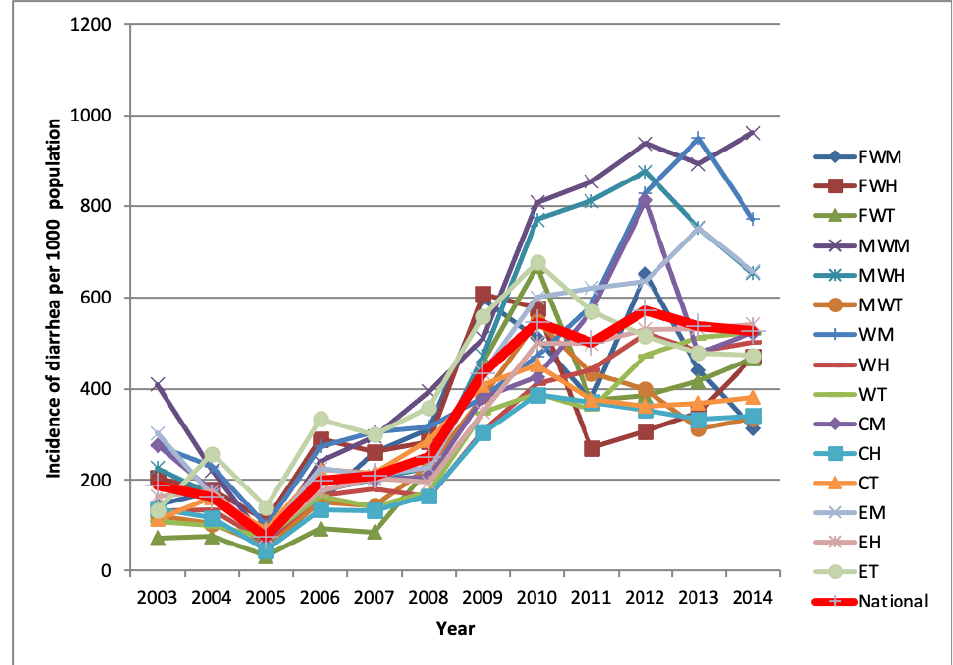
Figure 3. Trend of diarrheal disease by eco-development regions in Nepal (Source: HMIS Data, 2002 – 2014) .